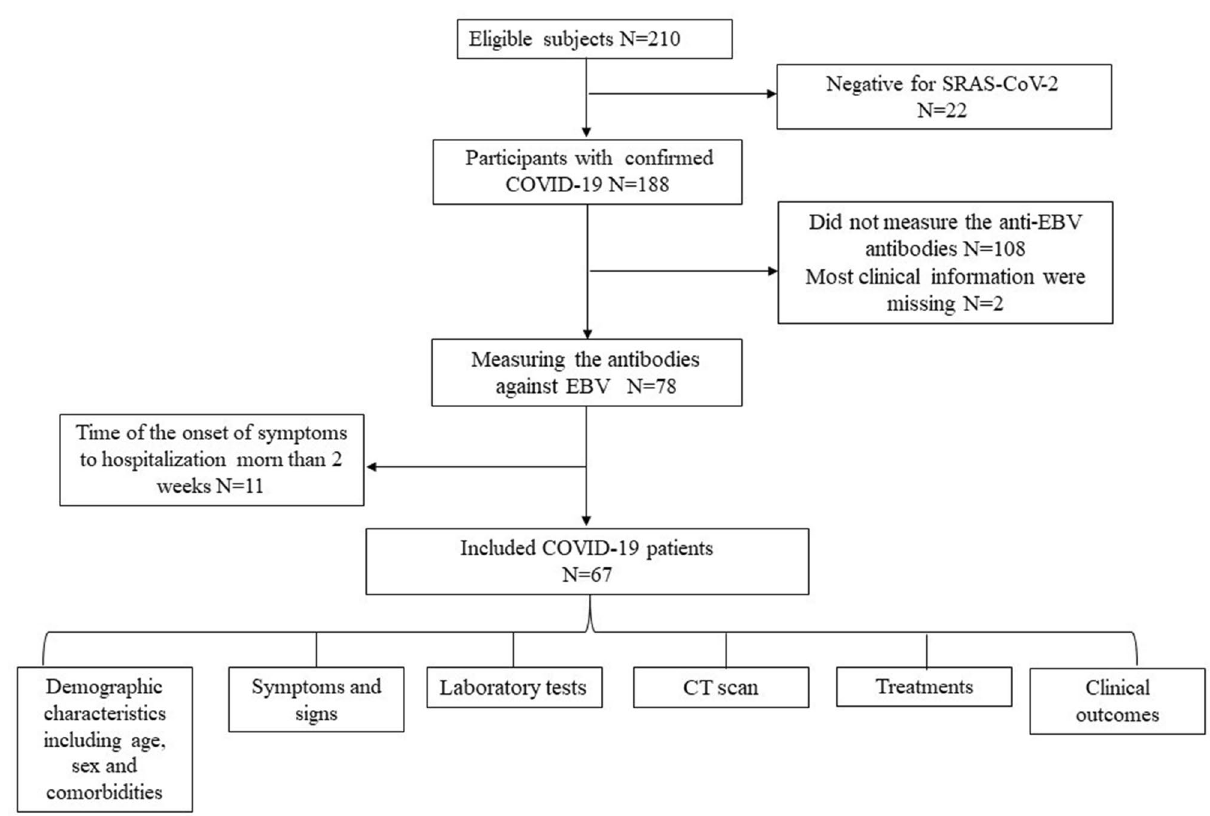
Figure 1. The workflow of corona virus disease 2019 (COVID-19) patients’ inclusion and exclusion